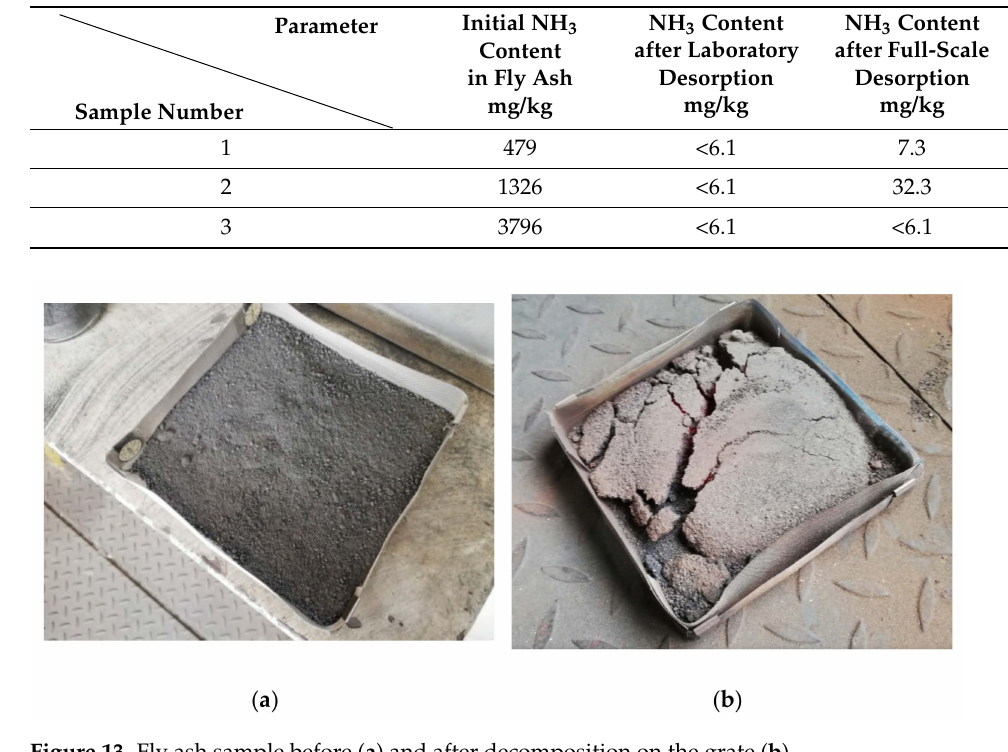
Table 7. NH 3 content in fly ash before and after thermal treatment in the laboratory and field scale.